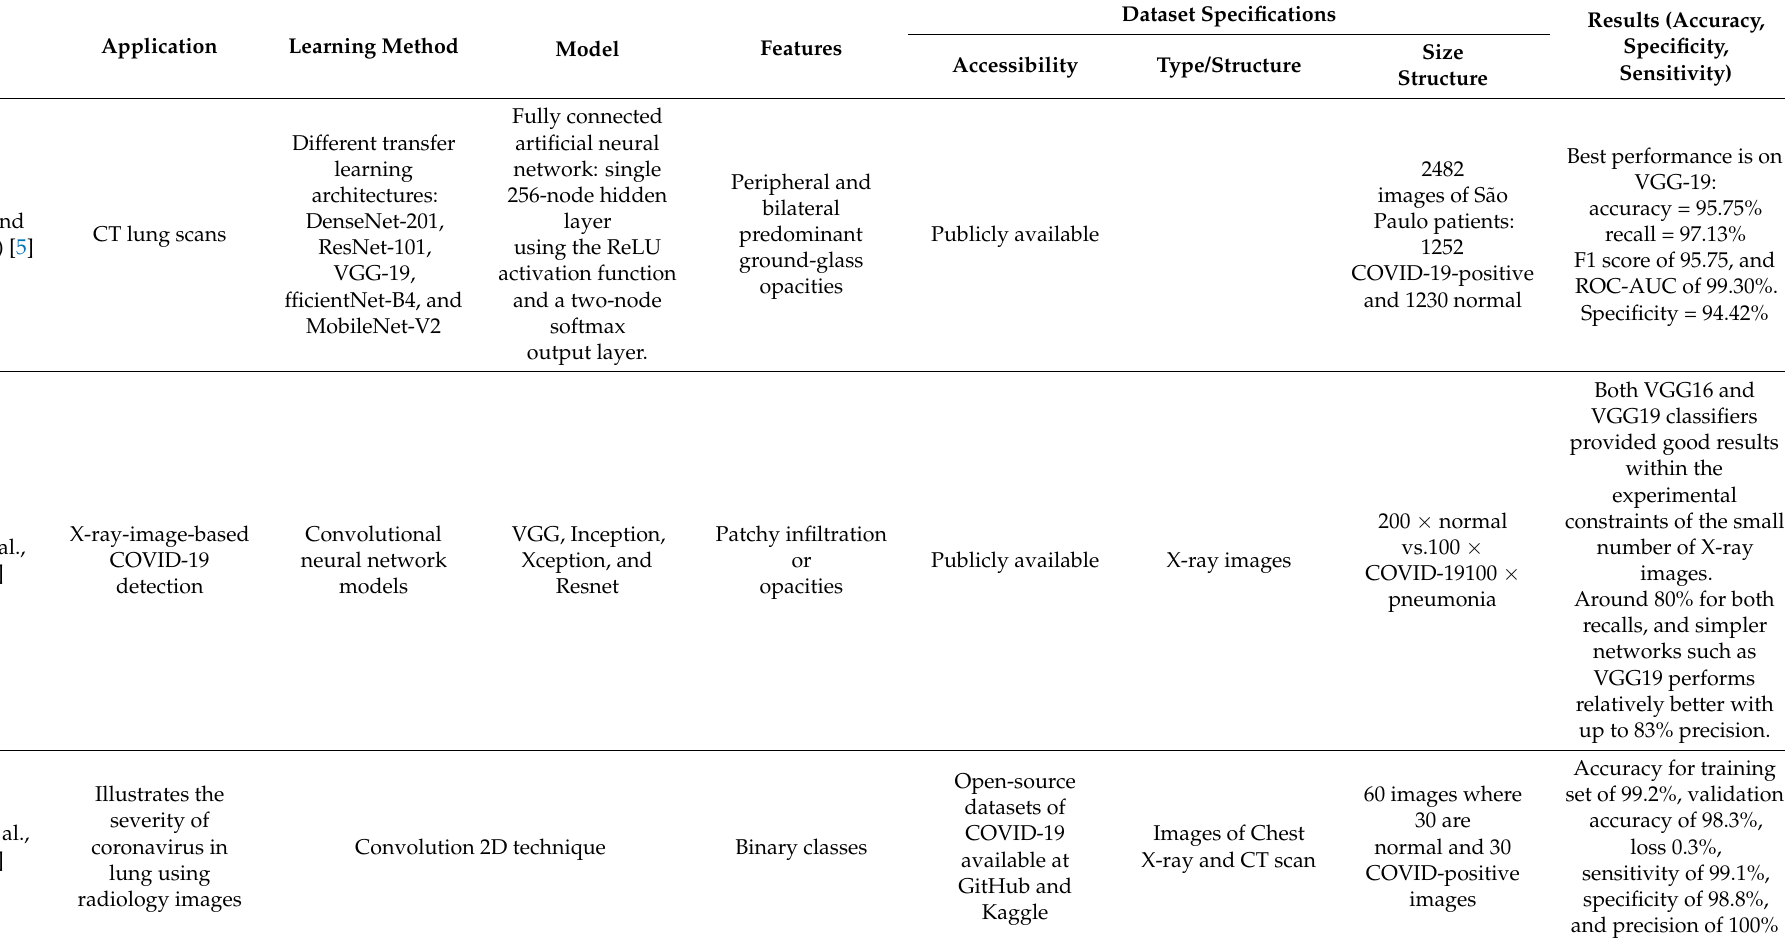
Table 1. Recent studies proposing learning model for classifying images to detect